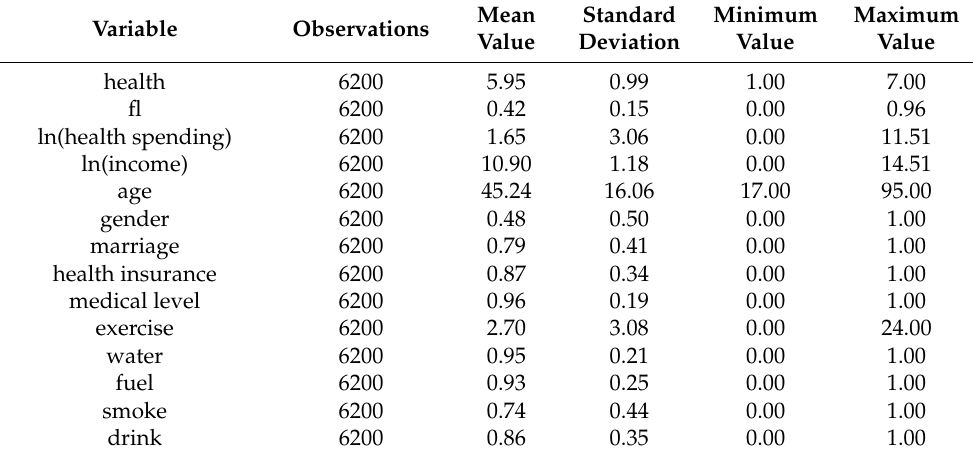
Table 3. Descriptive statistics of